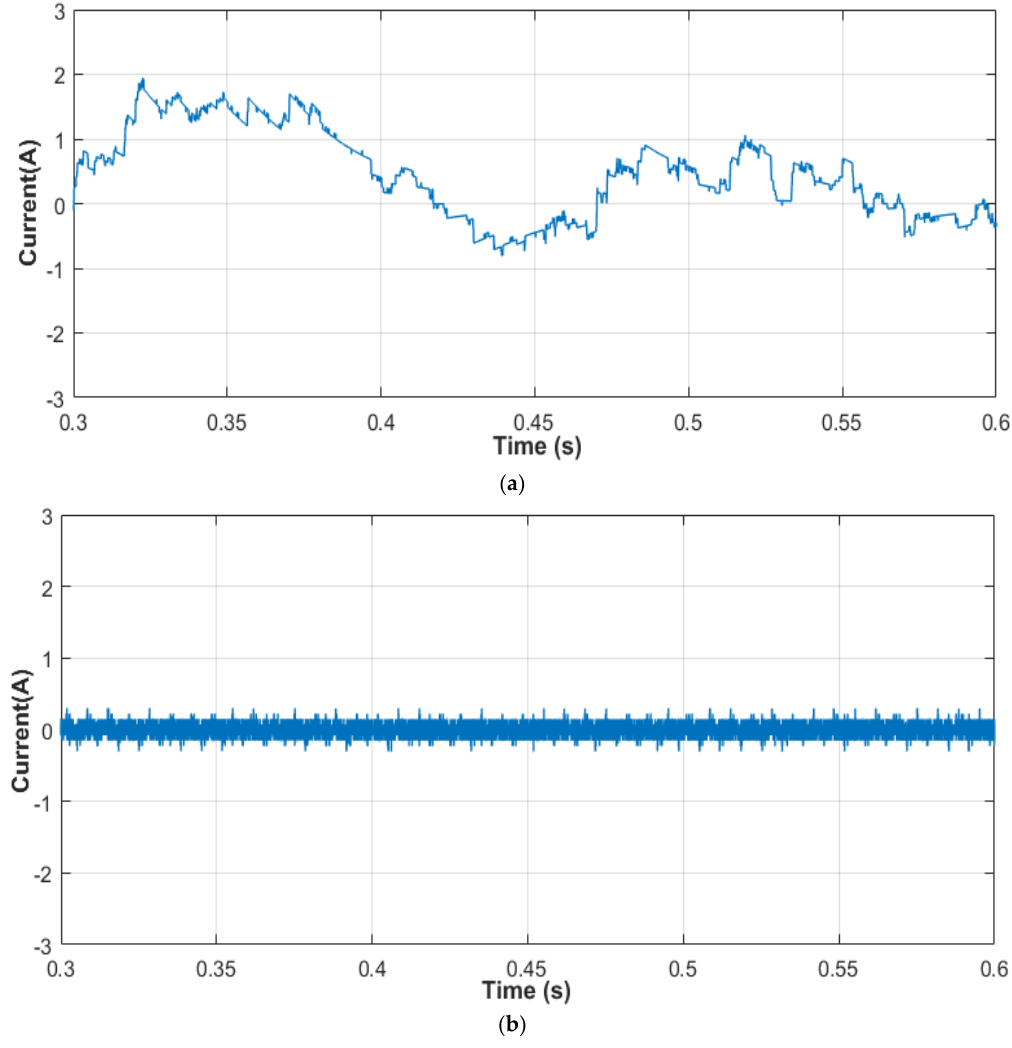
Figure 10. ZSCC of parallel system in equal inductance condition: ( a ) without any ZSCC suppression strategy; ( b ) with the proposed ZSCC suppression strategy.